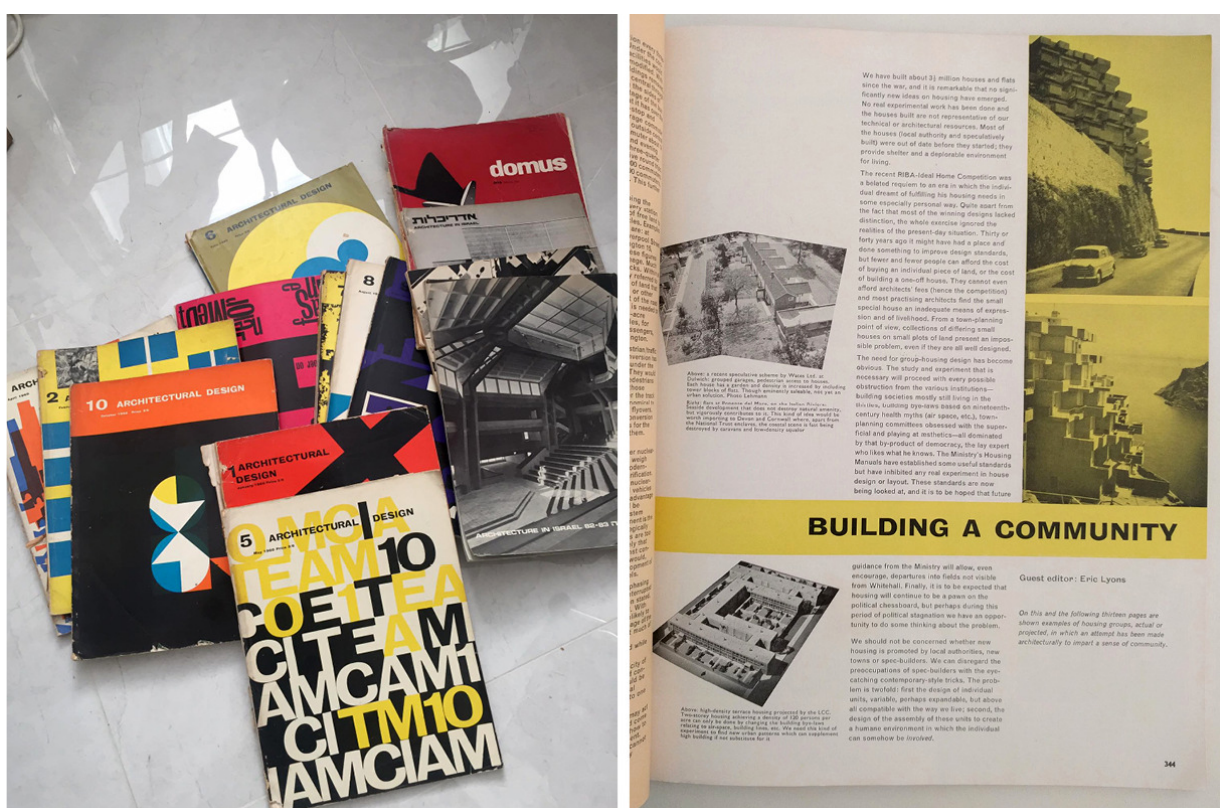
Figure 3. A collection of the Architectural Design journal issues found in architect Eli Mashiah’s private archive, the team architect of Be’eri at Sharon’s office. Sources: Courtesy of Idith